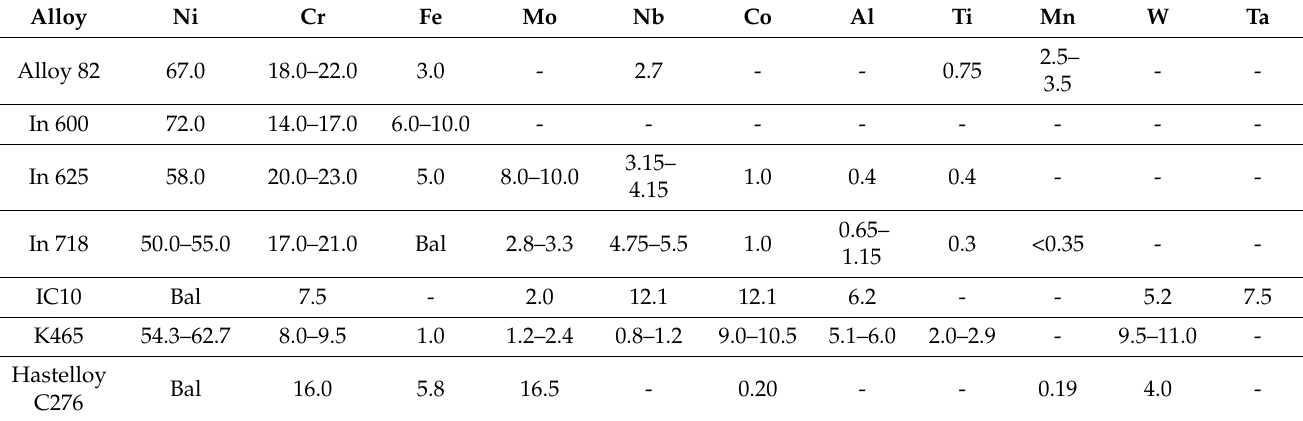
Table 1. Chemical composition of the most common heat-resistant nickel-based superalloys